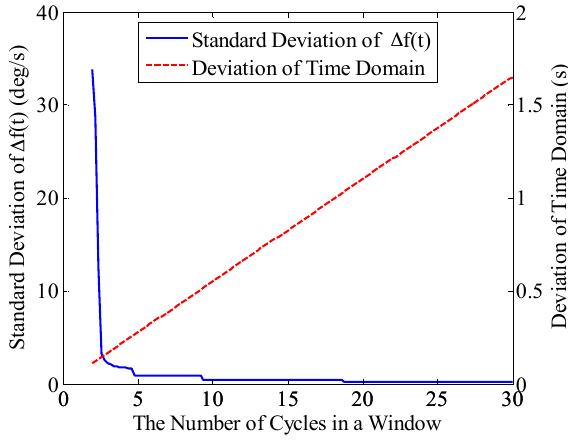
Figure 6. Impact of measurement window width on the accuracy of the BCZT.